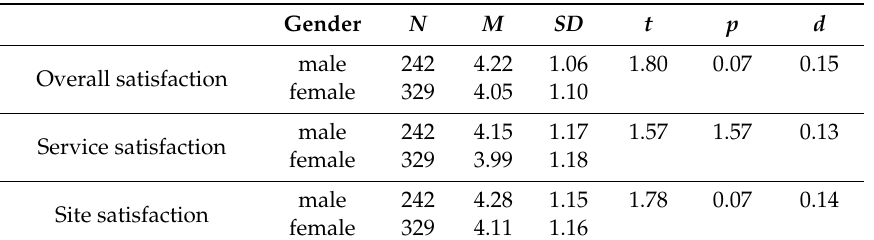
Table 3. t test for satisfaction by